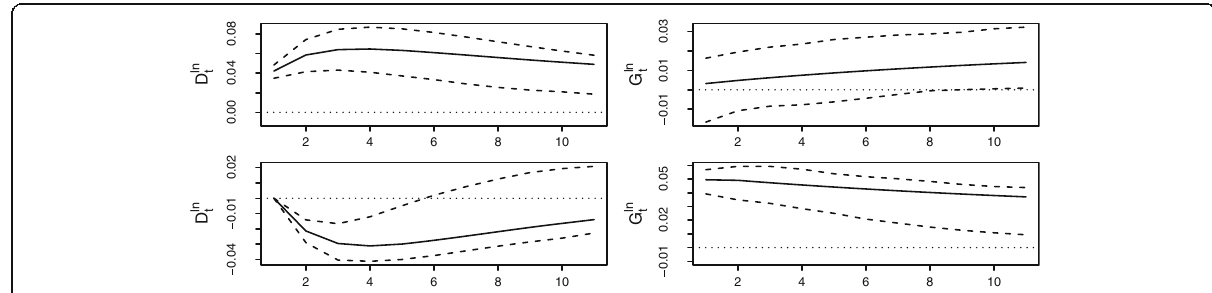
Fig. 3 Orthogonal impulse response functions with 95% bootstrap CI for all phases. Top: from D ln